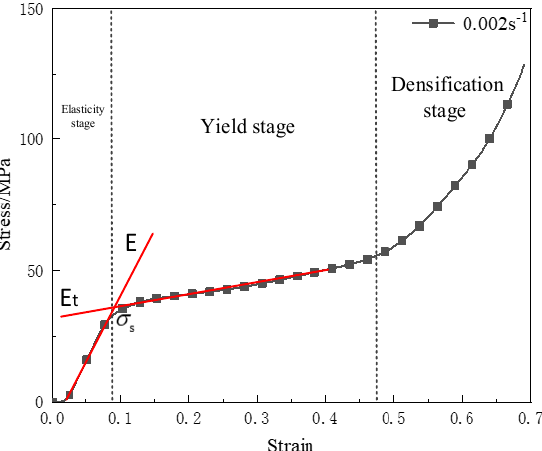
Figure 2. Schematic diagram of quasi–static compression performance parameters.